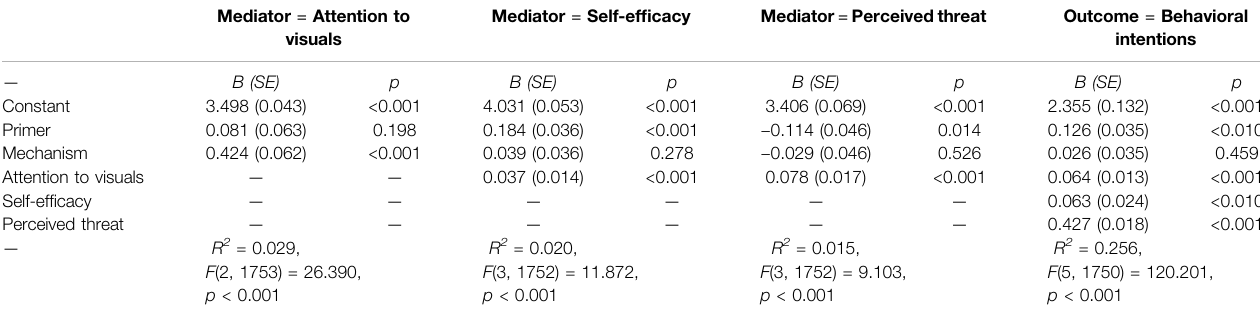
TABLE 3 | The serial mediation model of the effects of course types on preventive behavioral intentions via attention to visuals, self-ef fi cacy, and perceived threat. Mediator = Attention to